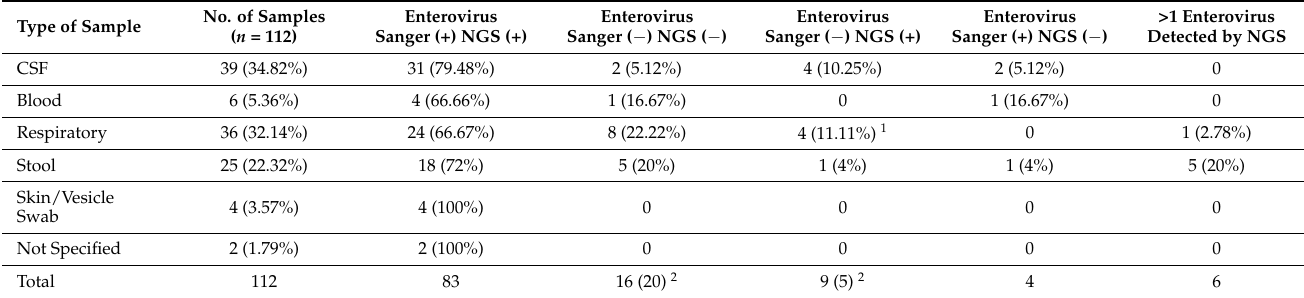
Table 1. Identification of enteroviruses (EVs) in 112 clinical samples from England using next generation sequencing (NGS) analysis compared with conventional Sanger sequencing by type of clinical sample. Type of